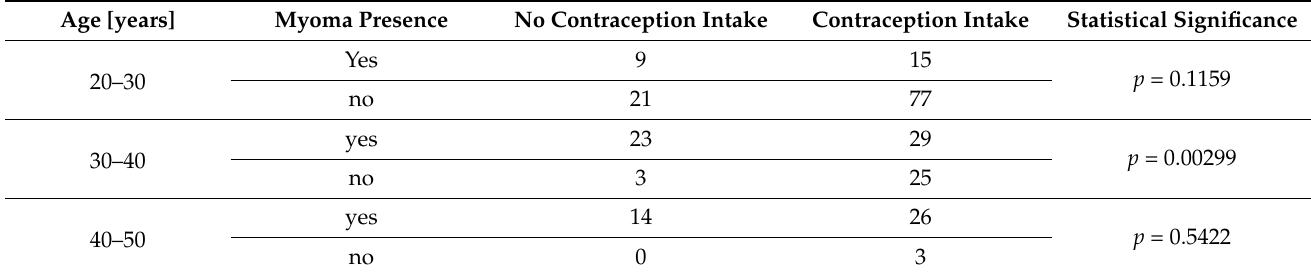
Table 3. Results of Chi2 test in the groups of patients divided according to age.